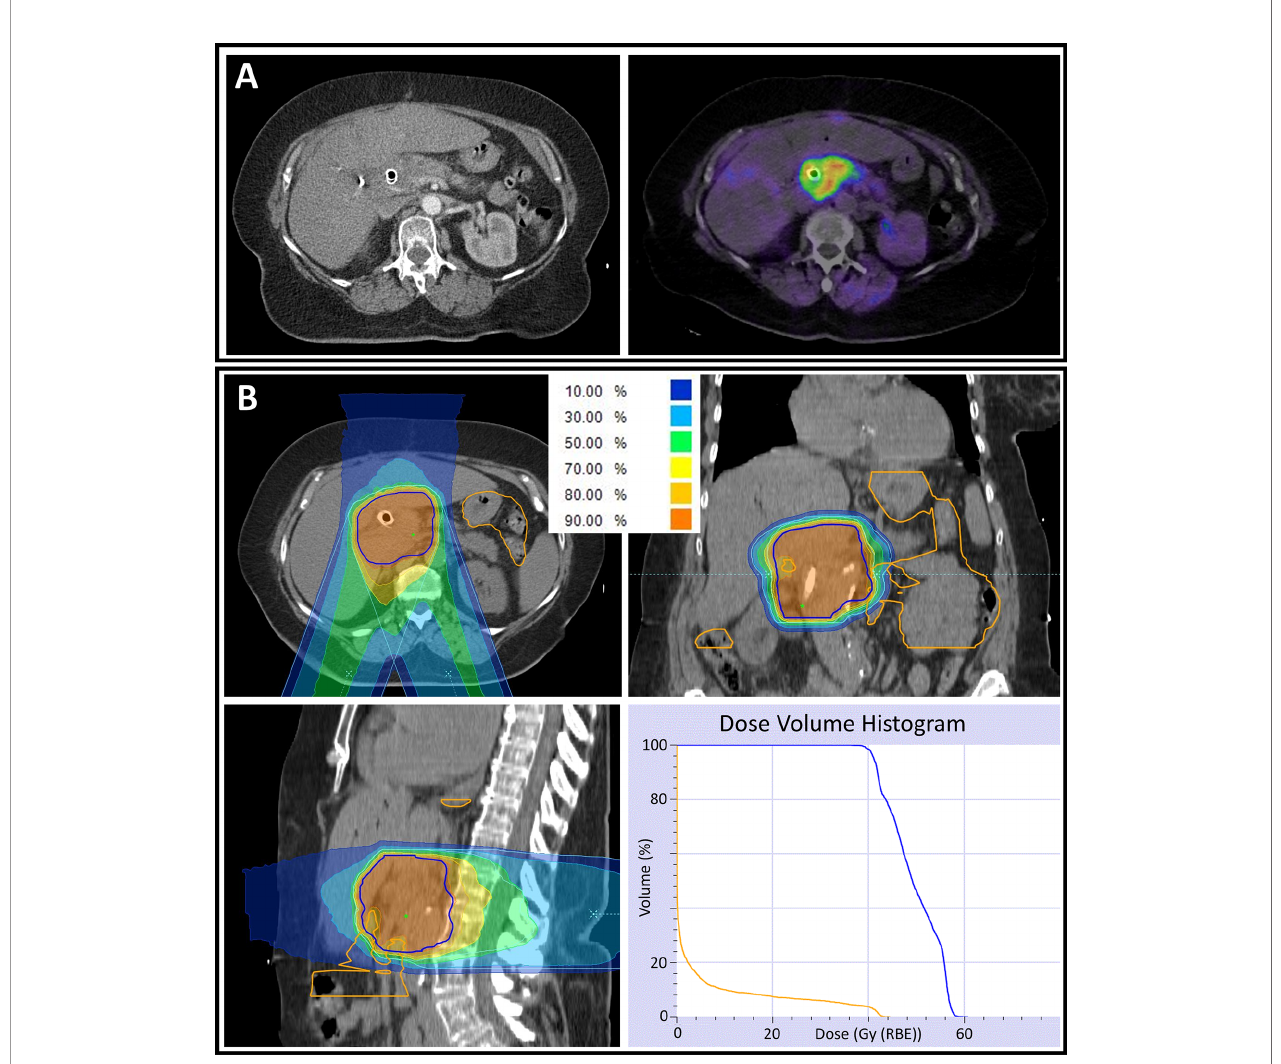
FIGURE 2 | (A) Computed tomography (CT) scan of a locally advanced pancreatic cancer patient demonstrating a pancreatic tumor mass with an implanted biliary metal stent (left). To improve target volume de fi nition in radiation planning, a fi broblast activation protein inhibitor-positron emission tomography (FAPI-PET) with a high tumor to background contrast was performed and matched with CT data (right). (B) Radiation plan of the same patient in axial (upper left), coronal (upper right) and sagittal (lower left) CT slices. The percentages of the different-colored isodose lines correspond to the prescribed dose of 48 Gy (RBE) in 12 fractions. For all volumes, an a / b -ratio of 2 Gy was used in the underlying relative biological effectiveness model. Partially, underdosage of the planning target volume (PTV, delineated in blue) needed to be accepted to respect the gastrointestinal (GI, delineated in orange) constraints. The dose volume histogram (lower right) demonstrates a ‘ stereotactic-radiotherapy-like ’ dose escalation within the PTV while respecting the GI